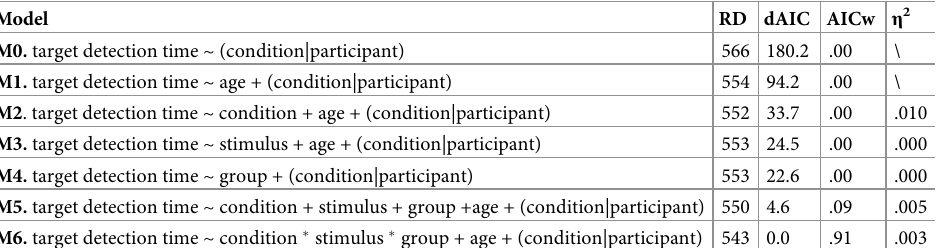
Table 1. The model selection for target detection time in milliseconds.